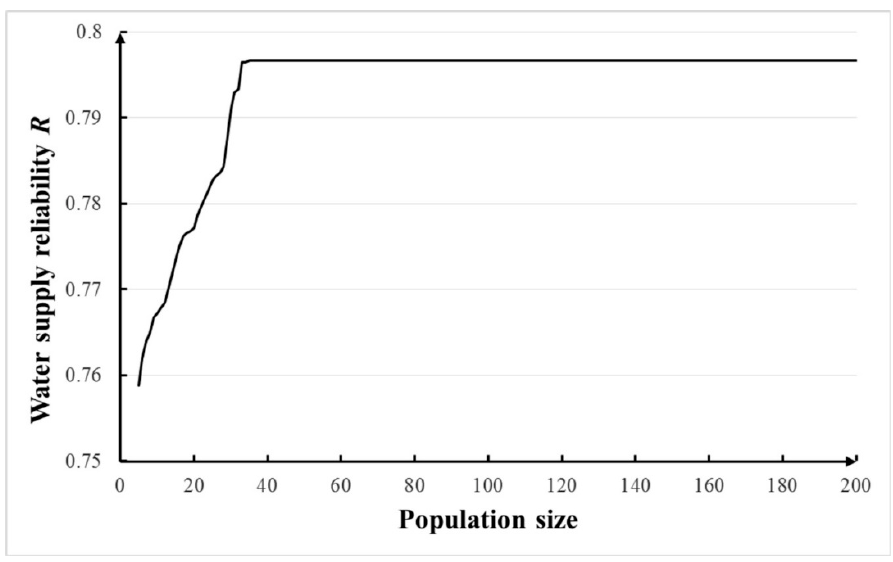
Figure 7. Sensitivity of population size in noisy GA.